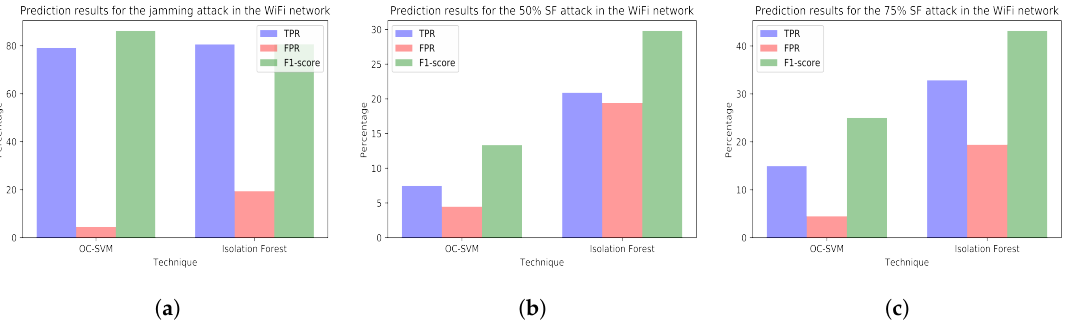
Figure 11. ( a ) prediction results for the jamming attack period using the variables from WiFi network (training with dataset tr_rpi and test with dataset te_rpi_jam ); ( b ) prediction results for the 50% selective forwarding attack period using the variables from WiFi network (training with dataset tr_rpi and test with dataset te_rpi_sf50 ); ( c ) prediction results for the 75% selective forwarding attack period using the variables from WiFi network (training with dataset tr_rpi and test with dataset te_rpi_sf75 ).